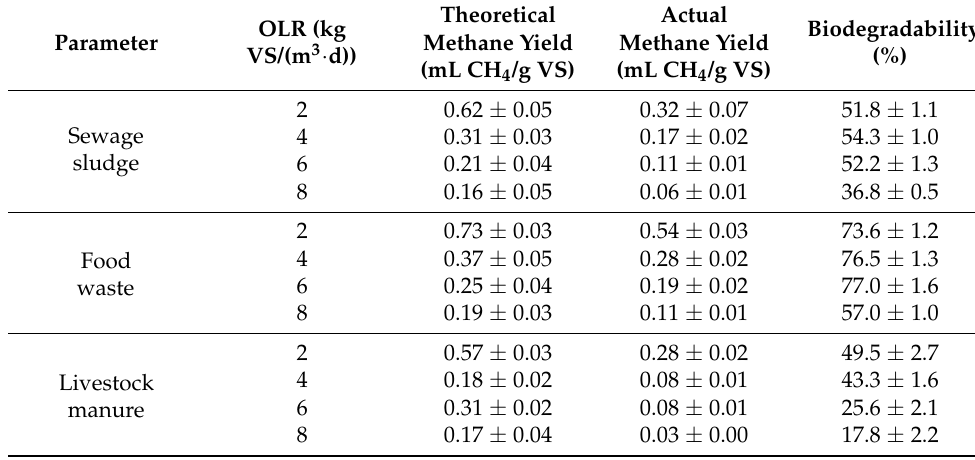
Figure 1. Cumulative methane yields of each organic waste under various organic loading rates of ( a ) 2 kg VS, ( b ) 4 kg VS, ( c ) 6 kg VS, and ( d ) 8 kg VS. Table 4. Biodegradability and volatile solids (VS)-based methane